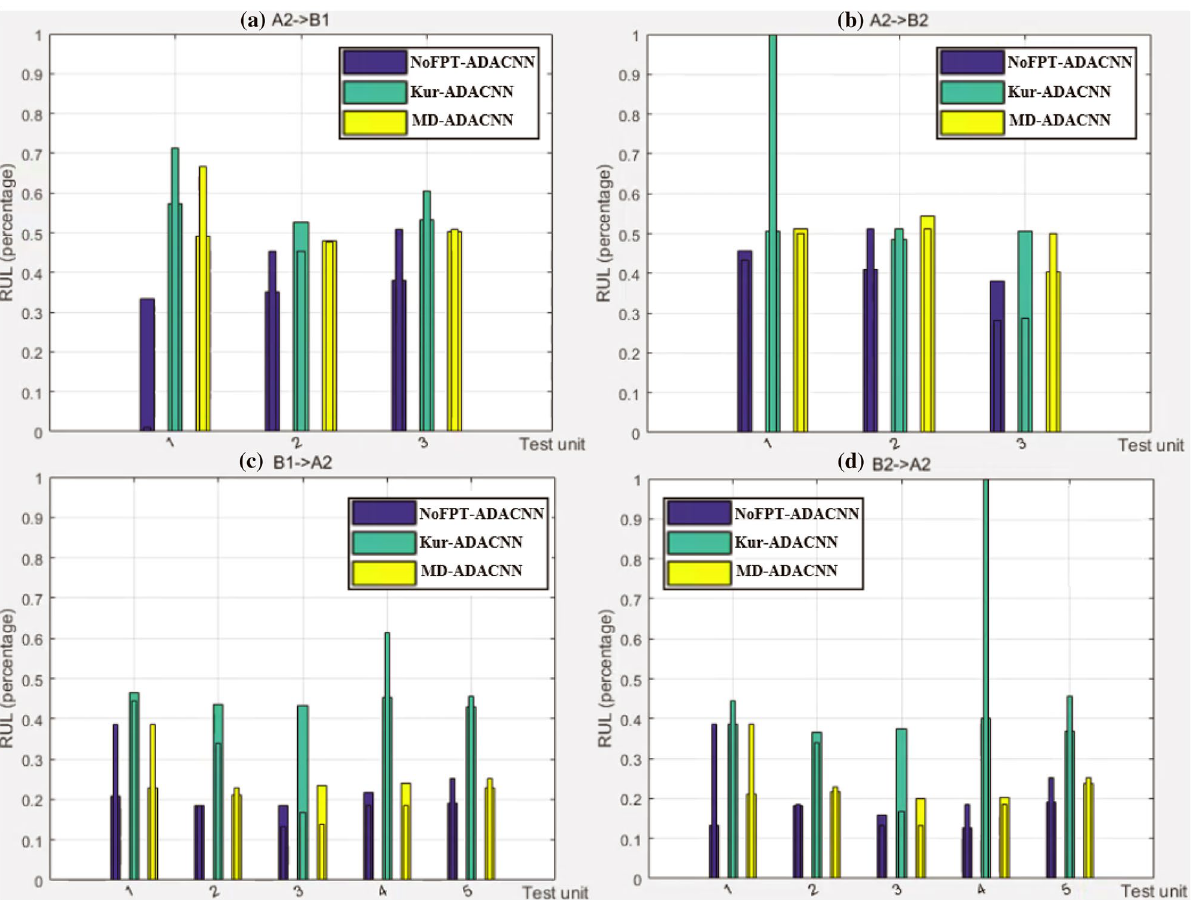
Figure 6. RUL estimation comparisons with different FPT detection mechanisms between two platforms: ( a ) E11: A2 −→ B1, ( b ) E12: A2 −→ B2, ( c ) E16: B1 −→ A2, ( d ) E19: B2 −→